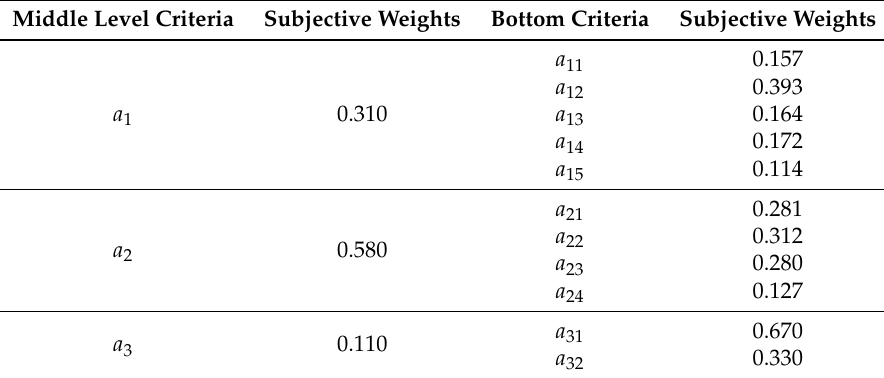
Table 3. Subjective weights of criteria.